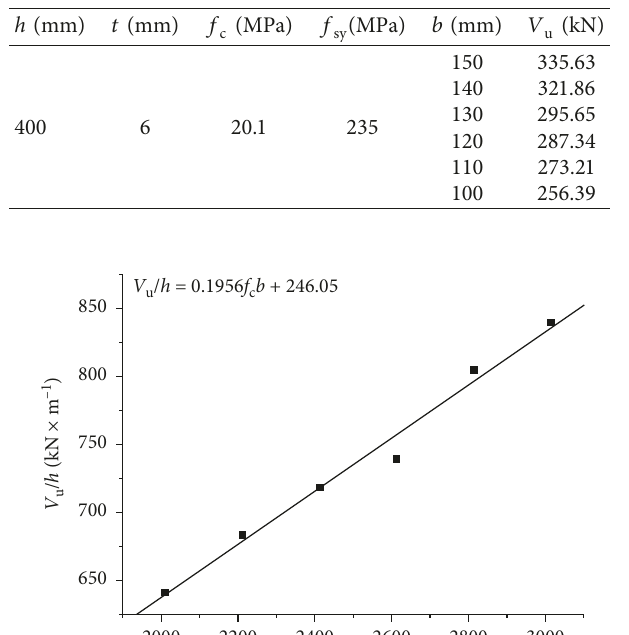
Table 6: Comparison of formula in this paper with test